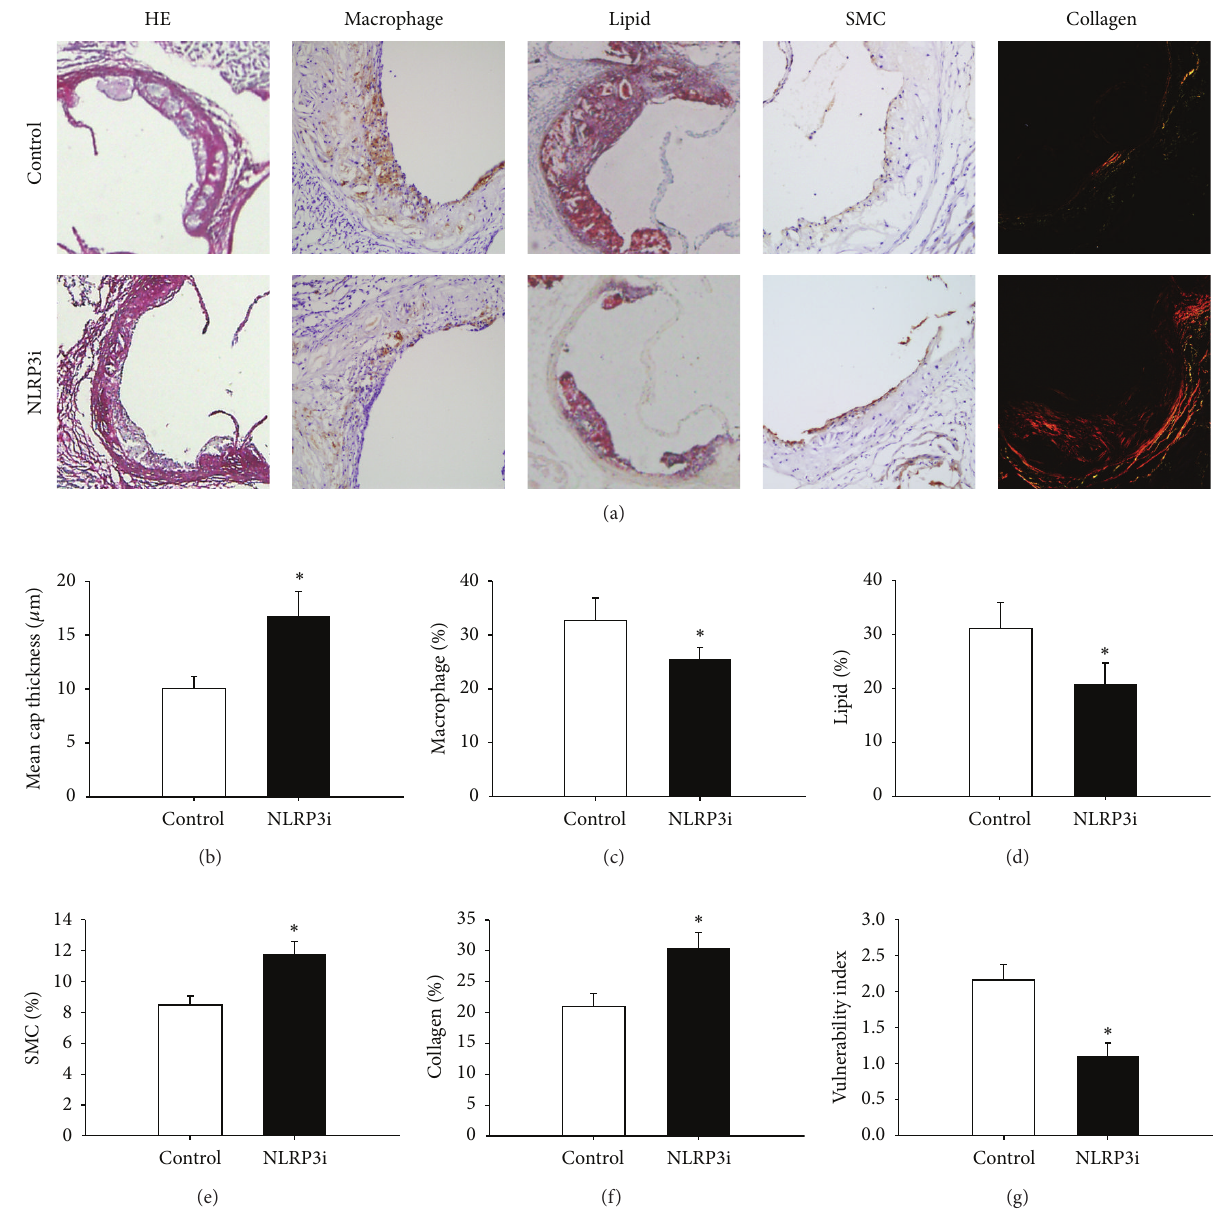
Figure 2: Cross sections of aortic root vessels from the control and gene interference groups were stained with H&E; vascular smooth muscle cells and collagen were immunostained with 𝛼 -actin and Sirius red, respectively; and macrophages and lipids were stained with MOMA-2 and oil red O, respectively (a). The mean cap thickness was increased after the NLRP3 silencing, compared with the control (b). Number of macrophages in the atherosclerotic lesion area was significantly lower by nearly 22% and lipid content was 33% lower with NLRP3 lentivirus than control transfection (c and d). SMCs content was higher by 39% and collagen content was 46% higher with NLRP3 lentivirus than control transfection (e and f). The vulnerability index was significantly lower in NLRP3i group than control (g). ∗ 𝑃 < 0.05 versus control. Values are mean ± SD. Scale bar is 100 𝜇